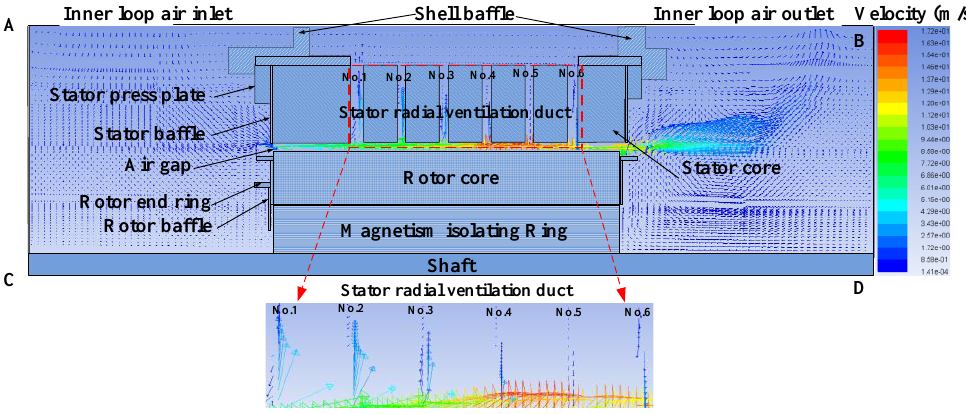
Figure 6. Fluid distribution within cross-section A-B-C-D of the motor with single ventilation path.